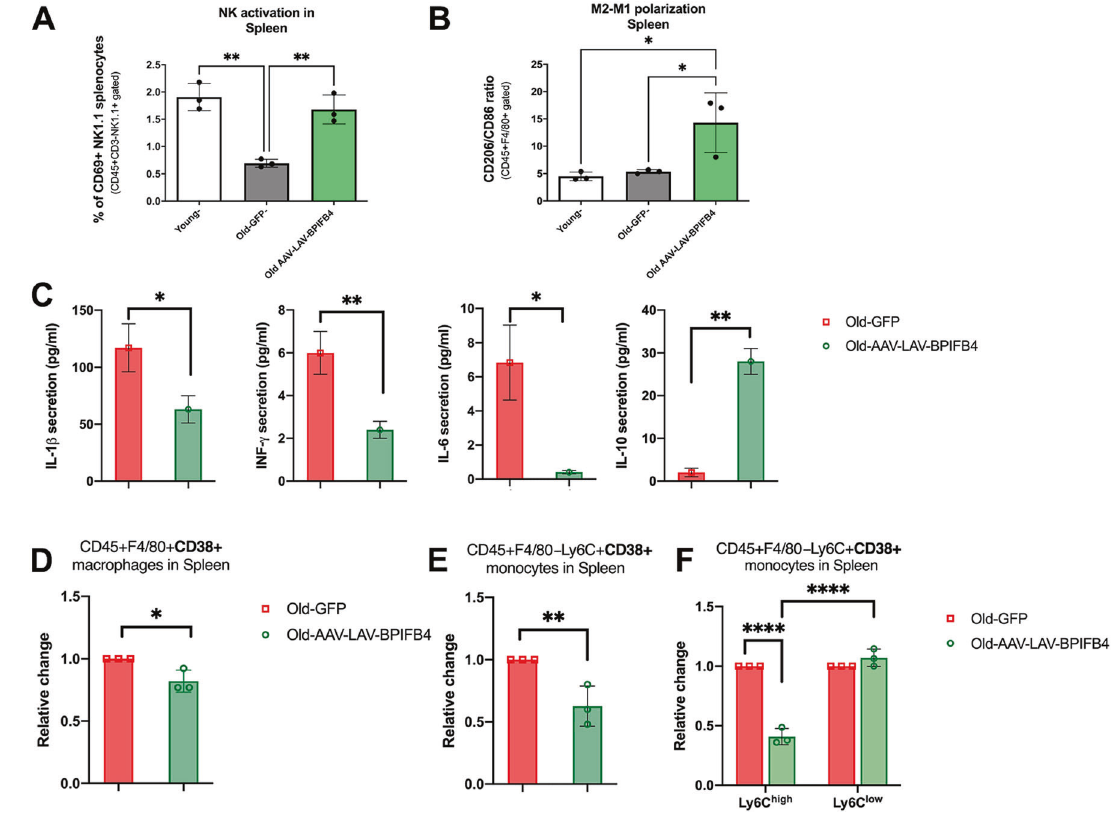
Fig. 3 Senescence pro fi le of spleen-resident immune cells and catabolic activity of AAV-LAV-BPIFB4 infection. A Flow cytometric quanti fi cation of the percentage of gated CD69 + NK1.1 + among freshly isolated CD45 + CD3-NK1.1 + splenocytes in n = 3 Young, n = 3 Old-GFP, and n = 3 Old-LAV-BPIFB4 mice. B Flow cytometric quanti fi cation of the CD206 + /CD86 + ratio (indicative of the macrophage polarization into a M2 or M1 macrophage-like phenotype) among total CD11b + F4/80 + splenocytes in n = 3 Young, n = 3 Old-GFP and n = 3 Old-LAV-BPIFB4 mice. Results from each treatment group are expressed as mean ± SD. Pairwise comparisons statistically signi fi cant are indicated (* P < 0.05, ** P < 0.01). Statistical evaluation was carried out by unpaired t -test (GraphPad ® Prism) . C ELISA quanti fi cation of in fl ammatory cytokines levels in splenocytes conditioned media of n = 3 Old-AAV-LAV-BPIFB4 mice as against those of n = 3 Old-GFP mice (* P < 0.05, ** P < 0.01). Results are expressed as mean ± SD. Pairwise comparisons statistically signi fi cant are indicated (* P < 0.05, ** P < 0.01). Statistical evaluation was carried out by ordinary one-way ANOVA corrected for Tukey ’ s multiple comparisons test (GraphPad ® Prism). D Histogram shows the amount of CD45 + F4/ 80 + CD38 + spleen-resident macrophages in n = 3 aged mice infected with AAV-LAV-BPIFB4 compared to n = 3 mice with GFP infection (* P < 0.05). Results are expressed as mean ± SD in terms of relative change to maximize the effect compared to their absolute percentage values (Supplementary Fig. 4). Pairwise comparisons statistically signi fi cant are indicated (* P < 0.05). Statistical evaluation was carried out by ordinary one-way ANOVA corrected for Tukey ’ s multiple comparisons test (GraphPad ® Prism). E Bar graph shows the amount of CD45 + F4/80- Ly6C + CD38 + spleen-resident monocytes in n = 3 aged mice infected with AAV-LAV-BPIFB4 compared to n = 3 GFP-infected mice (** P < 0.01) expressed as mean ± SD in terms of relative change. Pairwise comparisons statistically signi fi cant are indicated (** P < 0.01). Statistical evaluation was carried out by ordinary one-way ANOVA corrected for Tukey ’ s multiple comparisons test (GraphPad ® Prism). F Frequency of CD45 + F4/80-Ly6C + CD38 + spleen-resident monocytes strati fi ed into Ly6C high and Ly6C low from n = 3 Old-AAV-LAV-BPIFB4 mice vs n = 3 Old- GFP mice is reported (**** P < 0.001). Results are expressed as mean ± SD. Pairwise comparisons statistically signi fi cant are indicated (**** P